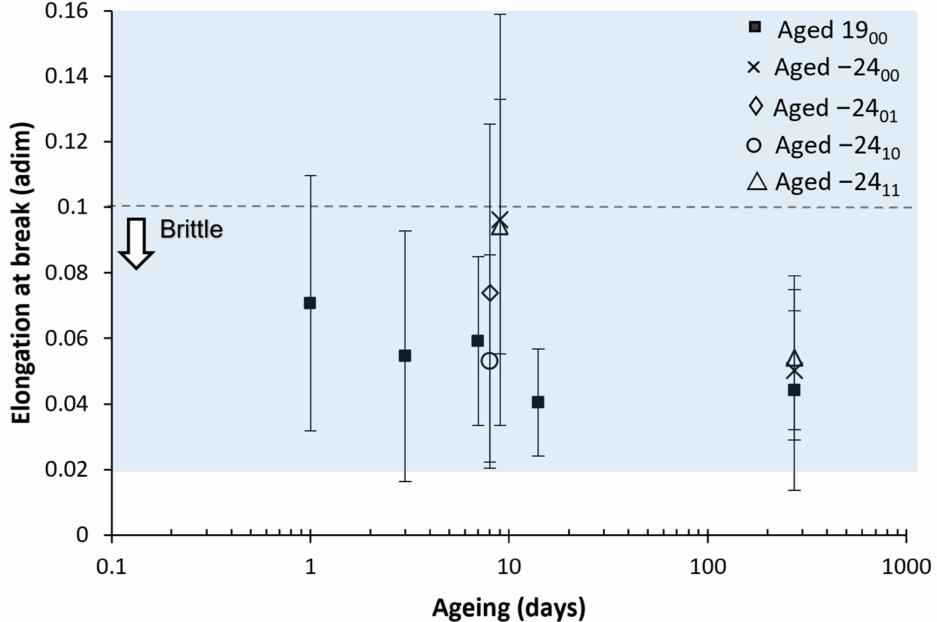
Figure 12. The average value of the elastic modulus with its mean square error versus the ageing. The shadow area shows the frozen sample value interval. For better visualisations, samples aged nine days are separated into 8 and 9 days in the graph, but all correspond with nine days. Six samples were measured for each ageing conditions and error bars are the standard deviation.